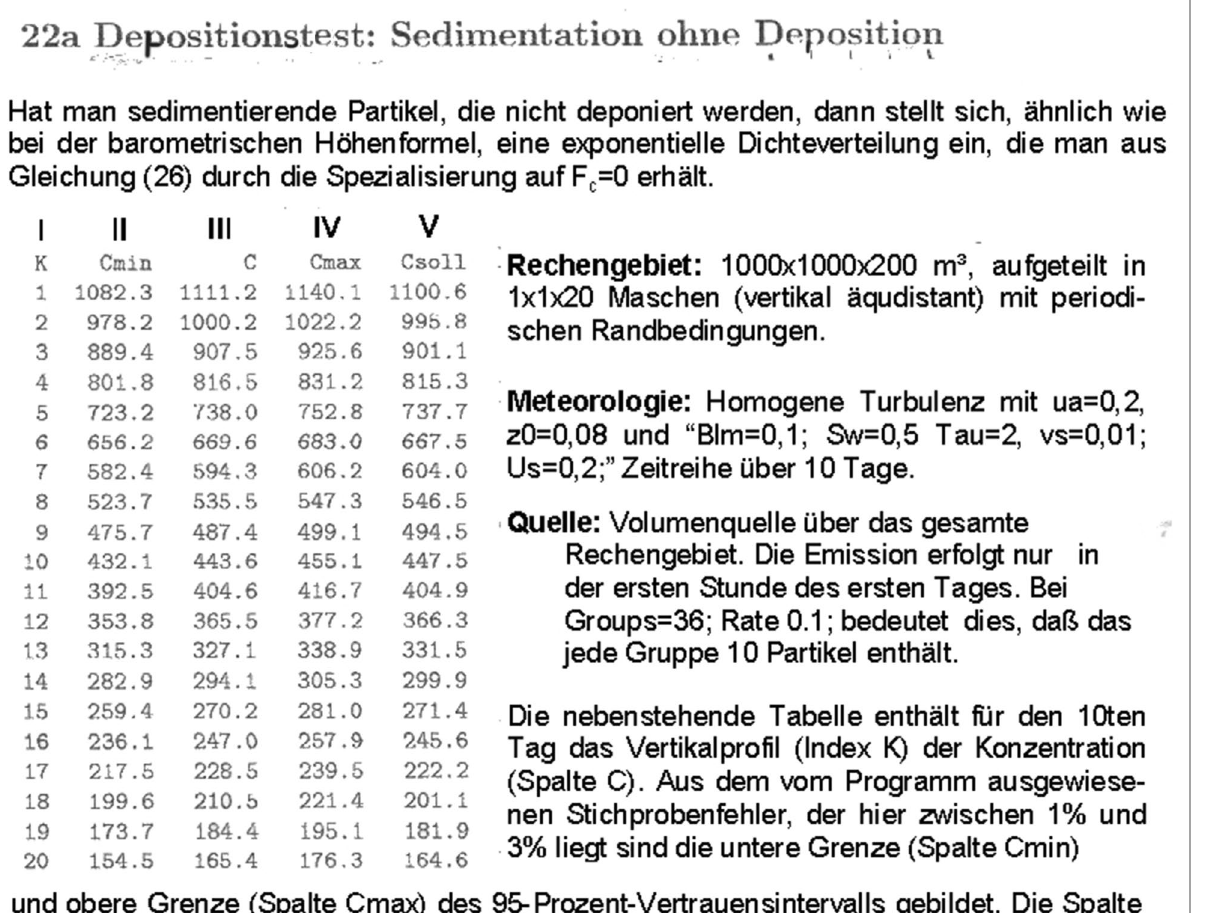
For t > T E and because of Eq. (39) as well as Eq. (4), ˙ q = 0 and dc / dt = 0 , this solution cannot be developed further. The concentration of c = 500 reached remains constant over time. Equation (40) describes zero-dimen- sional propagation with the time coordinate as the only independent variable.